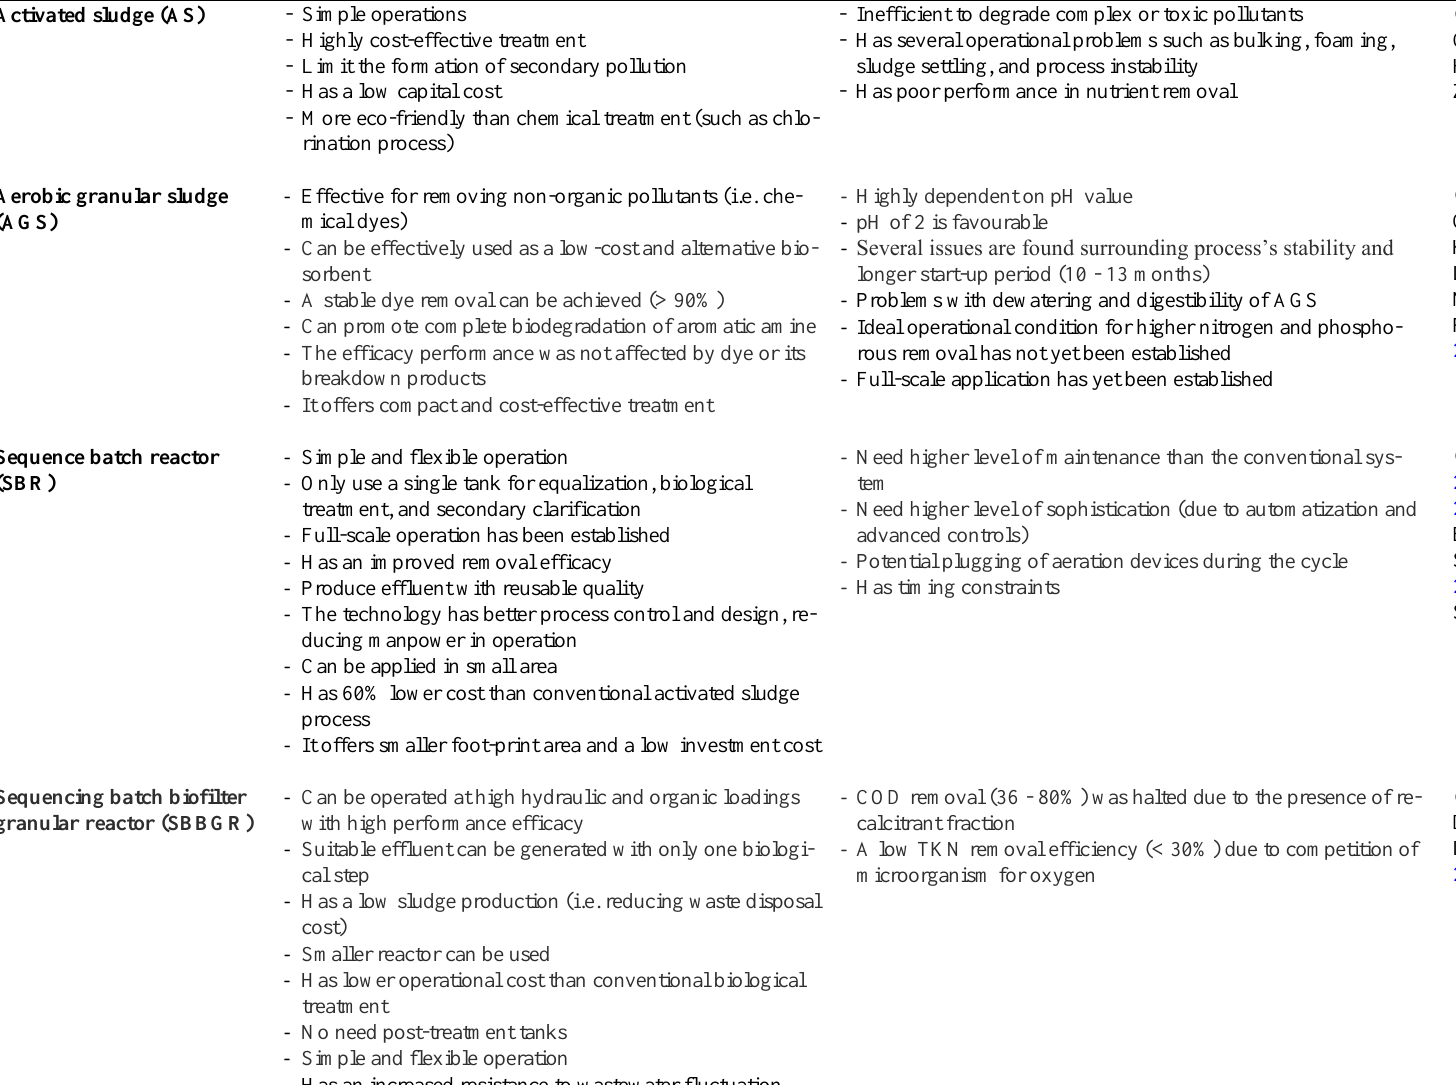
Table 3 Comparison of wastewater treatment technologies from various studies